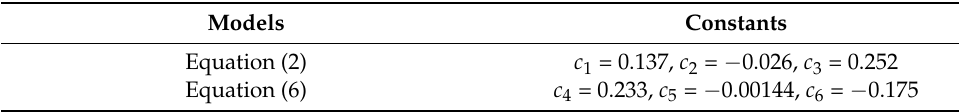
Table 2. Parameters of the experimental models’